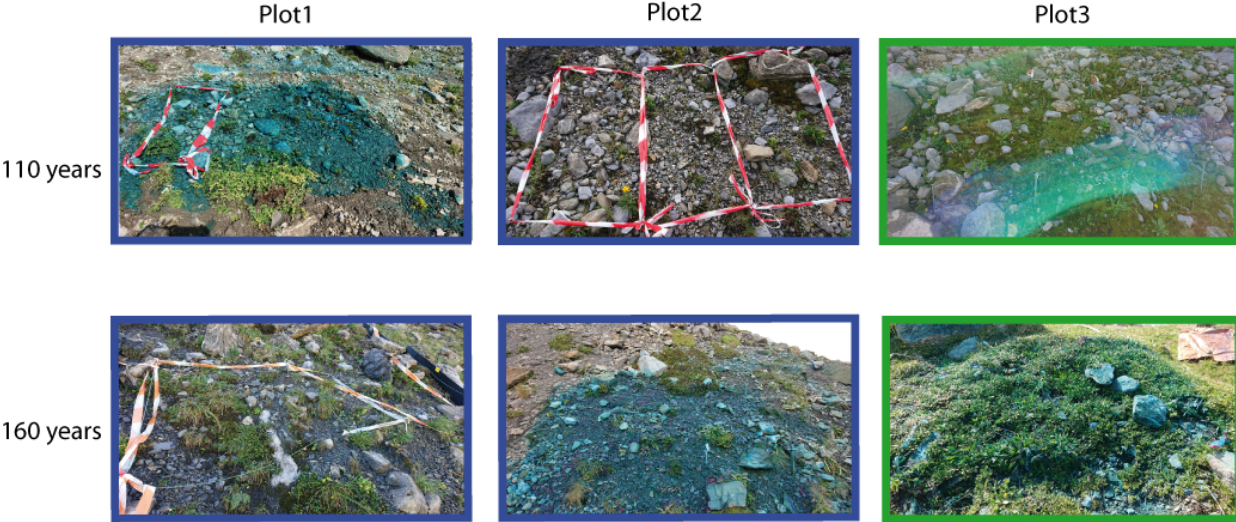
Figure 12. Surface of the plots at the 110- and 160-year-old moraine. Frame color indicates plots with a similar degree of vegetation coverage. Photograph of the high complexity plot at 110-year-old moraine is disrupted by lens flares due to